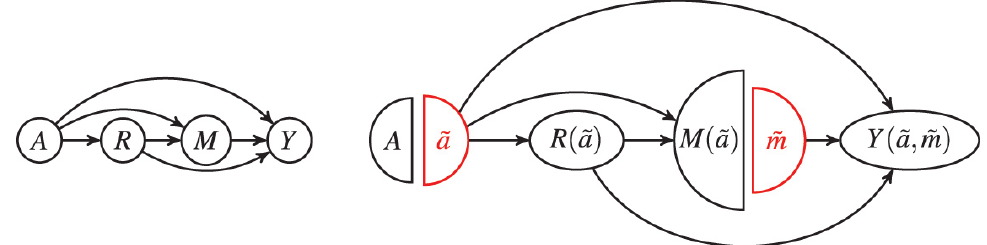
Figure 2: (A) A mediation uuu in which u is an exposure-induced confounder. The nodes represent random variables, and the arrows represent possible causal effects of one random variable on another. (B) The single-world intervention graph in the setting of (A) that has been intervened on to set u to ̃u ∈ {u,u ∗ } and u to ̃u . The black nodes represent random variables under this intervention, the red nodes represent the level an intervened random variable takes under this intervention, and the arrows represent possible causal effects of one variable under this intervention on